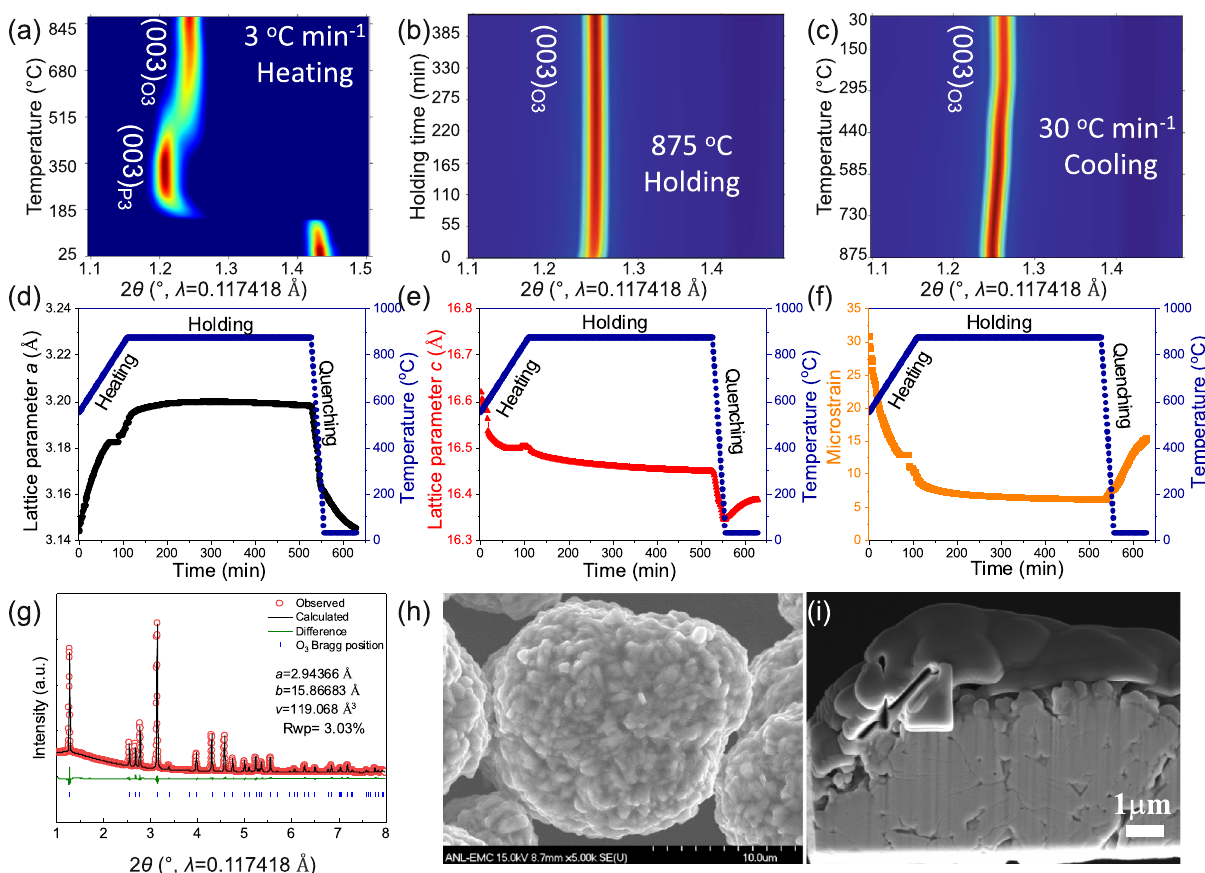
Fig. 1 Solid-state synthesis of O3 NaNi 0.4 Mn 0.4 Co 0.2 O 2 . 2D contour plot of in situ SXRD patterns during a heating, b holding, and c quenching process. The color in a – c represents the intensity, with red for highest and blue for lowest. d Lattice parameter a , e lattice parameter c and f microstrain evolution during the heating/holding/quenching process. g SXRD Rietveld re fi nement, h SEM image and i cross-section SEM image of the strained O3 NaNi 0.4 Mn 0.4 Co 0.2 O 2